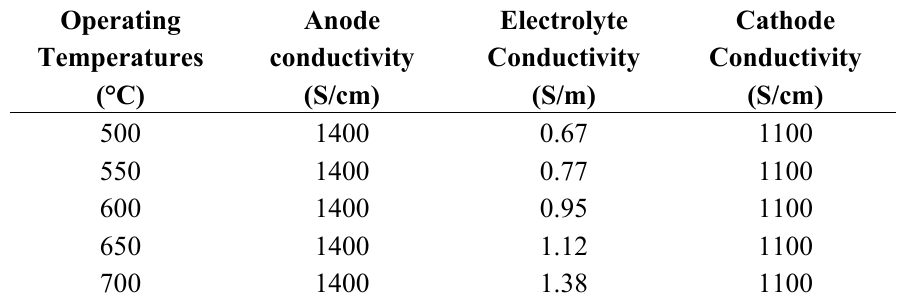
Table 5. Conductivities of electrode and electrolyte at different